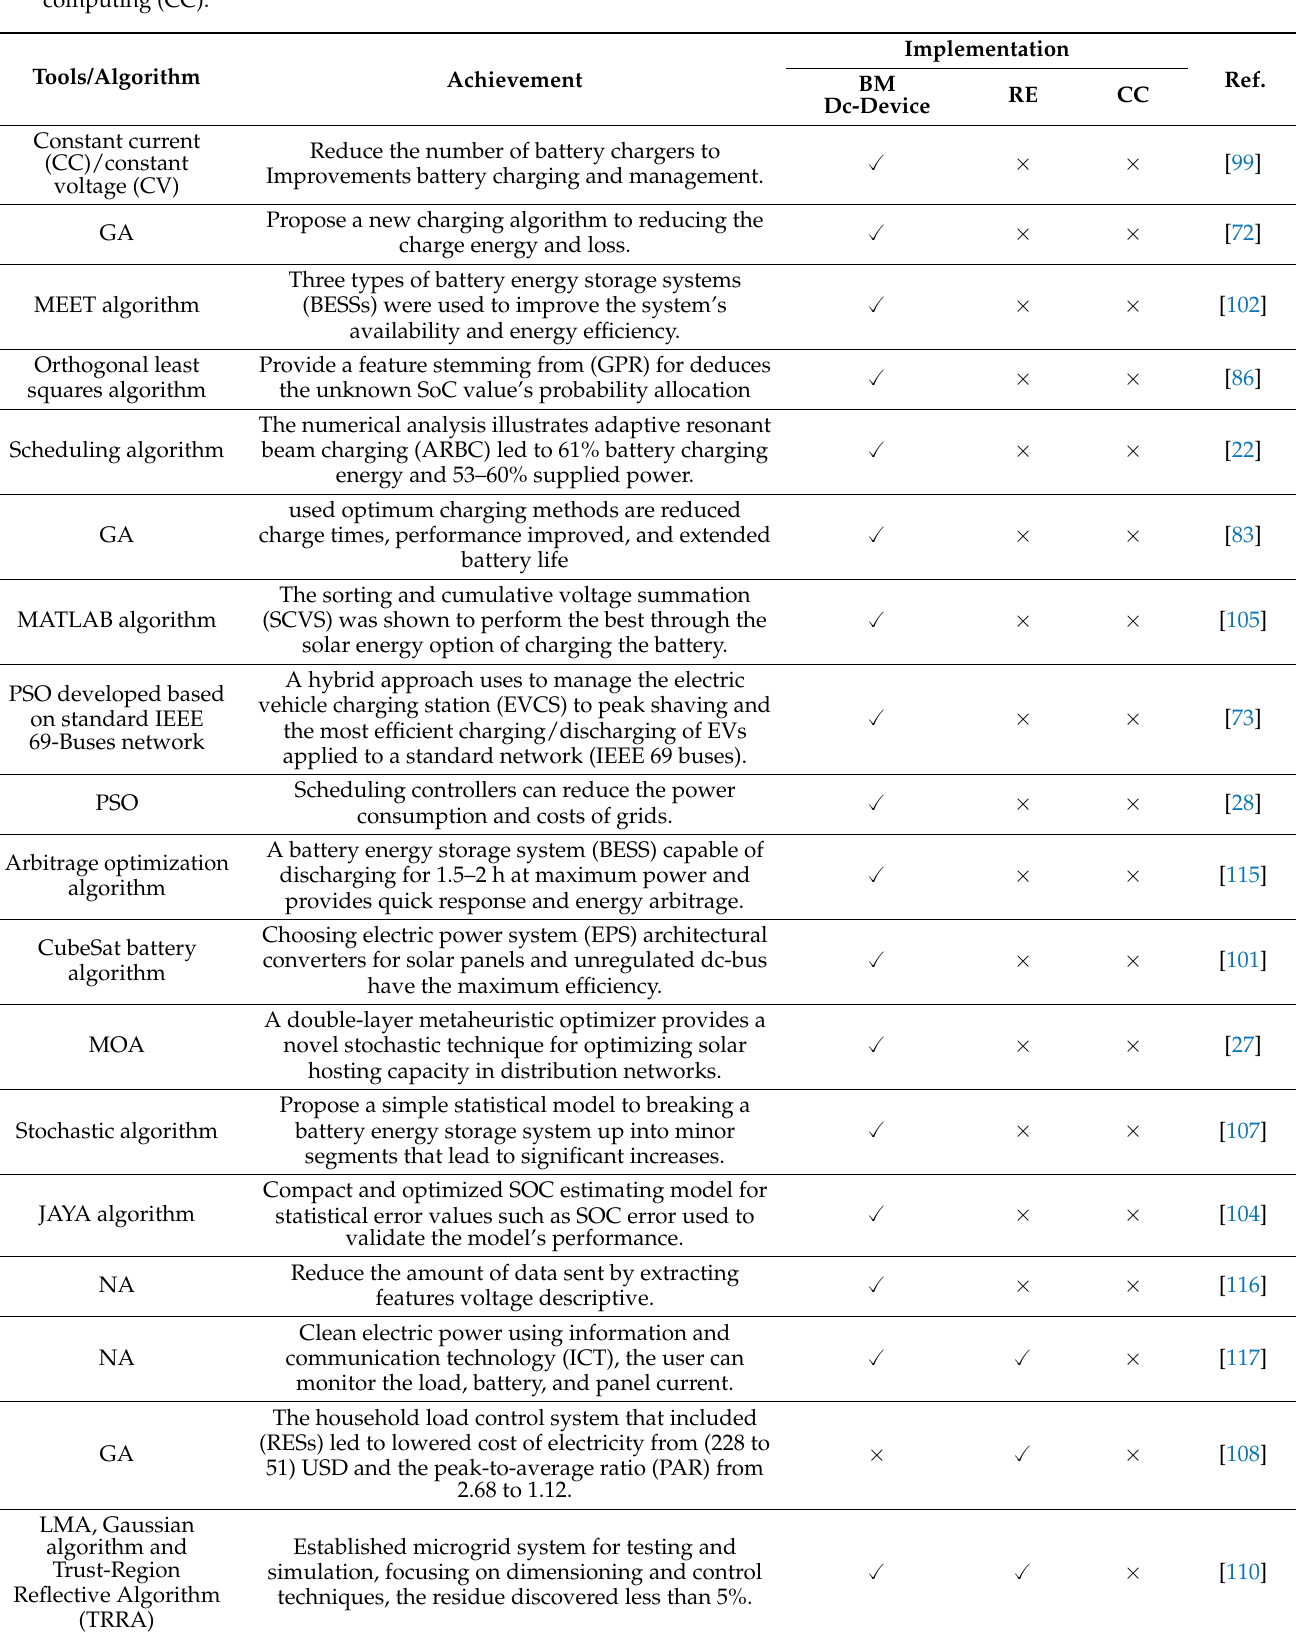
Table 2. Assessment and analysis of the literature studies for battery management (BM), renewable energy (RE), and cloud computing